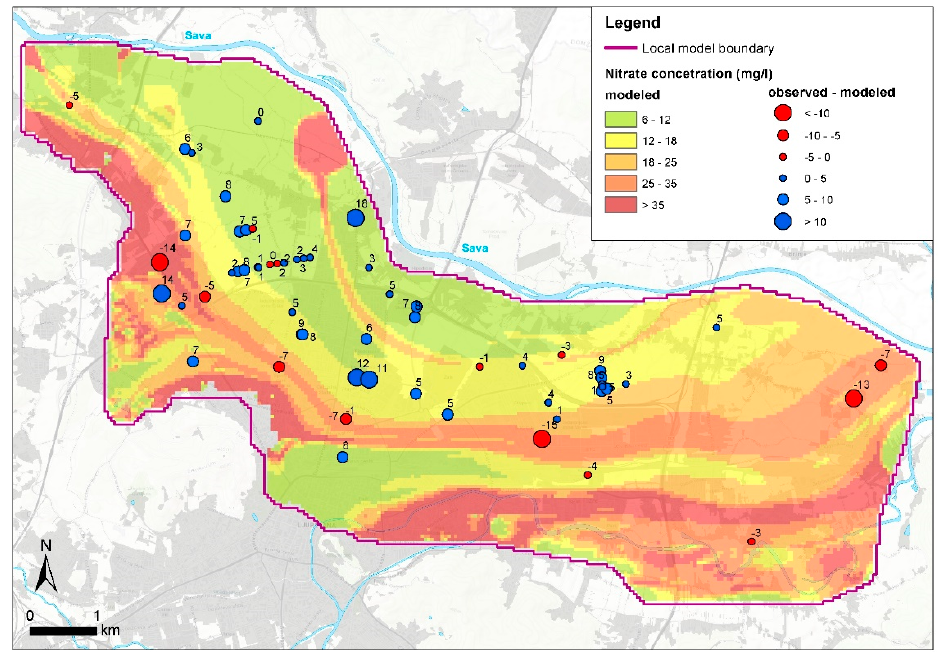
Figure 9. Spatial distribution of differences between the observed and the modeled nitrate concentrations in the groundwater in mg/L with red showing and overestimation by the model.